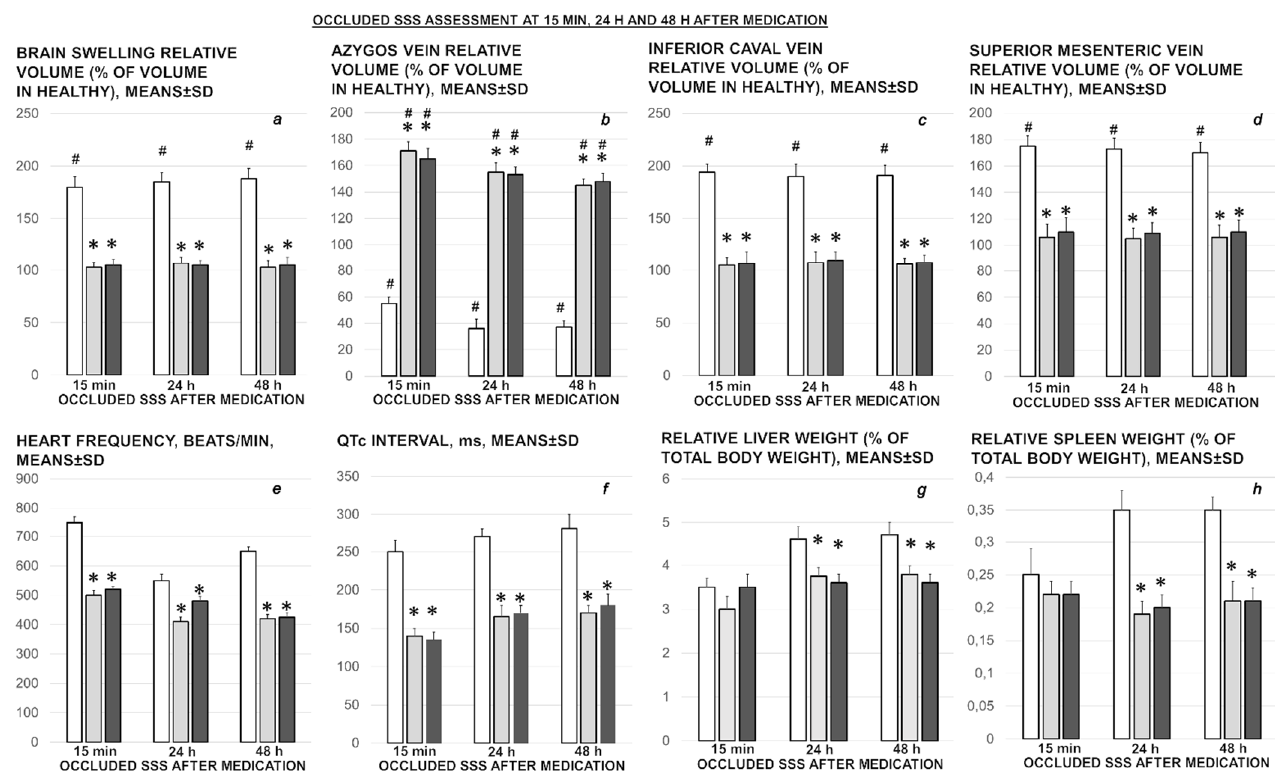
Figure 1. Brain and blood vessels presentation assessed as the relative volume, % of volume in healthy, before ligation (100%), and then in the rats with occluded superior sagittal sinus, immediately after ligation (occluded superior sagittal sinus (SSS) before medication, white bars), and then after therapy (occluded superior sagittal sinus (SSS) after medication) at 1 min, 5 min, and 10 min ligation-time. Therapy was saline 5 mL/kg (white bars), BPC 157 10 µg/kg (light gray bars), 10 ng/kg (dark gray bars). In the assessment of the brain swelling progress or elimination, the medication effect was shown when given intragastrically ( a ), locally at the swollen brain ( b ), or intraperitoneally ( c ); or intragastrically with azygos ( d ), superior mesenteric ( e ), and inferior caval vein ( f ) assessment (while the effects of the intraperitoneal and local application regimens, providing the similar results were not specifically shown). Means ± SD, * p ˂ 0.05, at least vs. corresponding control; # p ˂ 0.05, at least vs. regular healthy values.